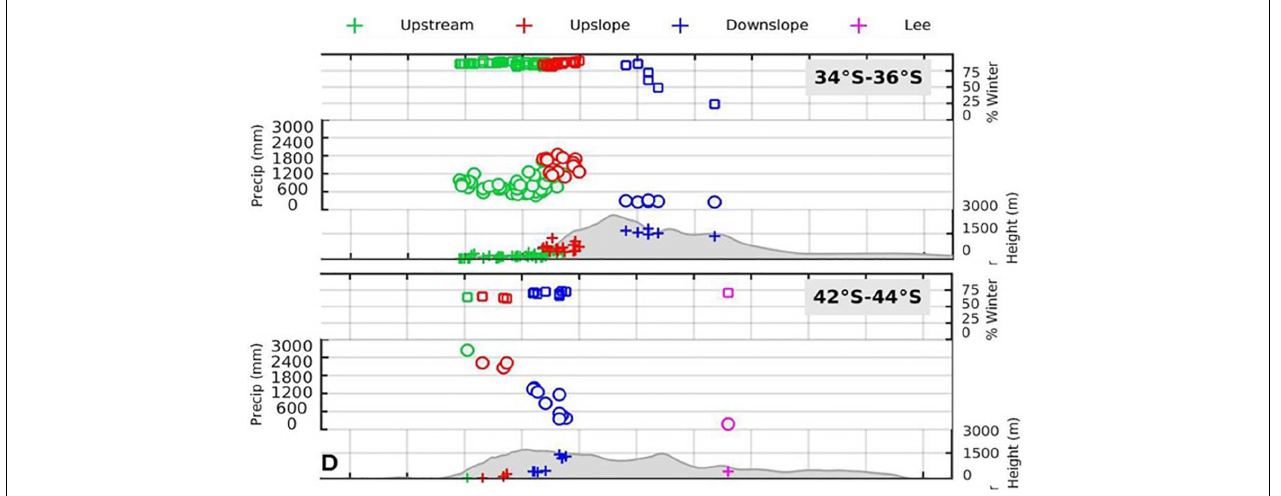
FIGURE 12 | Mean annual precipitation in different rain gauges of the Andes at subtropical (35 ◦ S) and extratropical (43 ◦ S) latitudes. In both cases, the figure is a west-east cross section including topography (gray shaded), annual mean precipitation (circles) in rain gauges (crosses). The boxes at the top indicate the fraction of precipitation that falls in austral winter (April–September). Adapted from Viale et al.